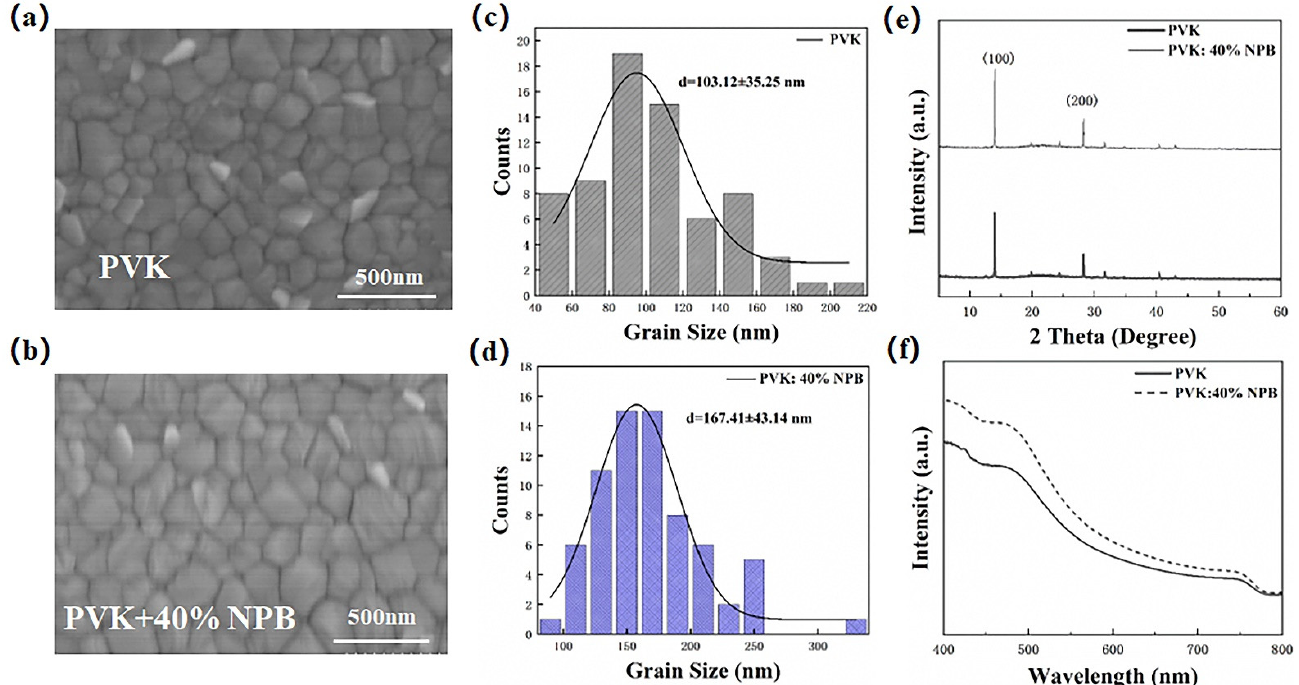
Figure 6. Top-view SEM images and the corresponding grain size distribution of MAPbI 3 film on top of ( a , c ) PVK and ( b , d ) PVK: 40% NPB; ( e ) XRD patterns and ( f ) UV–vis absorption spectra of MAPbI 3 films.